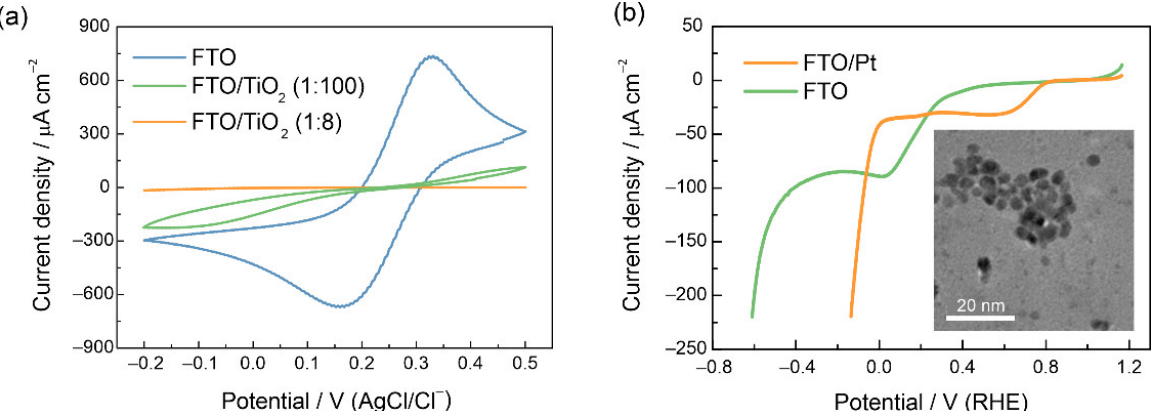
Figure 4. ( a ) Cyclic voltammograms at 25 mV s −1 of pristine FTO, FTO/TiO 2 (1:8), FTO/TiO 2 (1:100) electrodes in solution of 10 mM Fe(CN) 63- in 0.5 M Na 2 SO 4 . ( b ) Linear sweep voltammograms of FTO electrode with and without Pt nanoparticles at 25 mV s −1 . The insert shows TEM image of Pt nanoparticles.